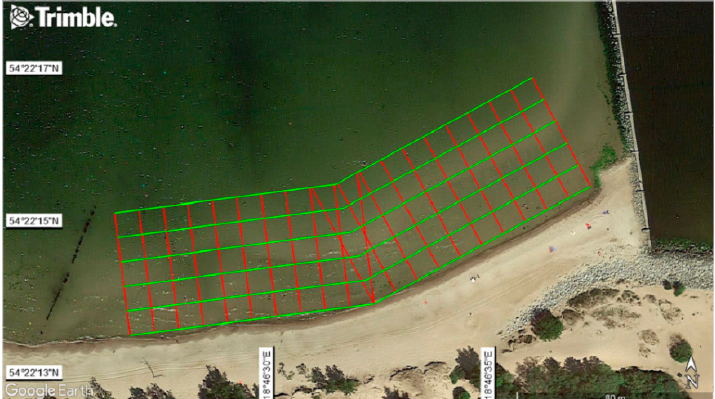
Figure 4. The system of main and control profiles in the territorial sea baseline determination for waterbody No. 3.